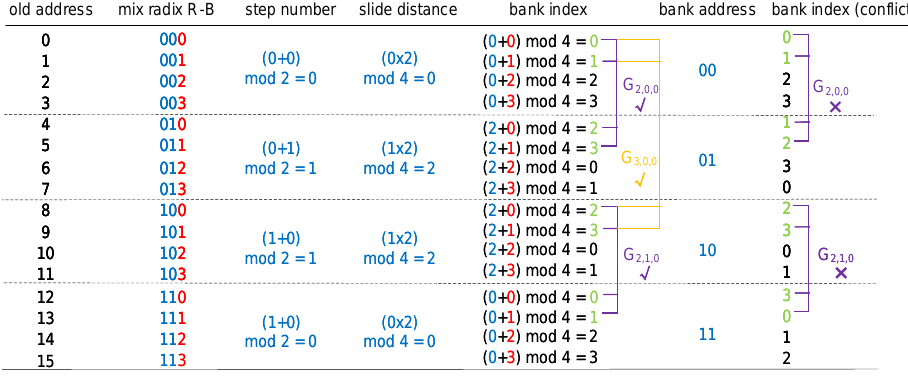
Figure 7: The detailed memory mapping scheme for 16 points radix-2 NTT with d =